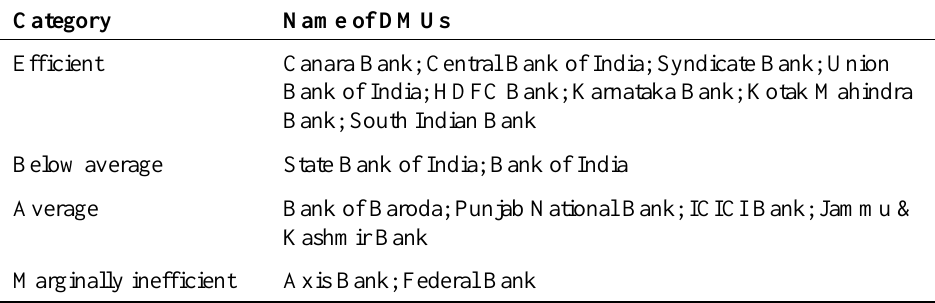
Table 4: Classification of Banks Based on OTE Score